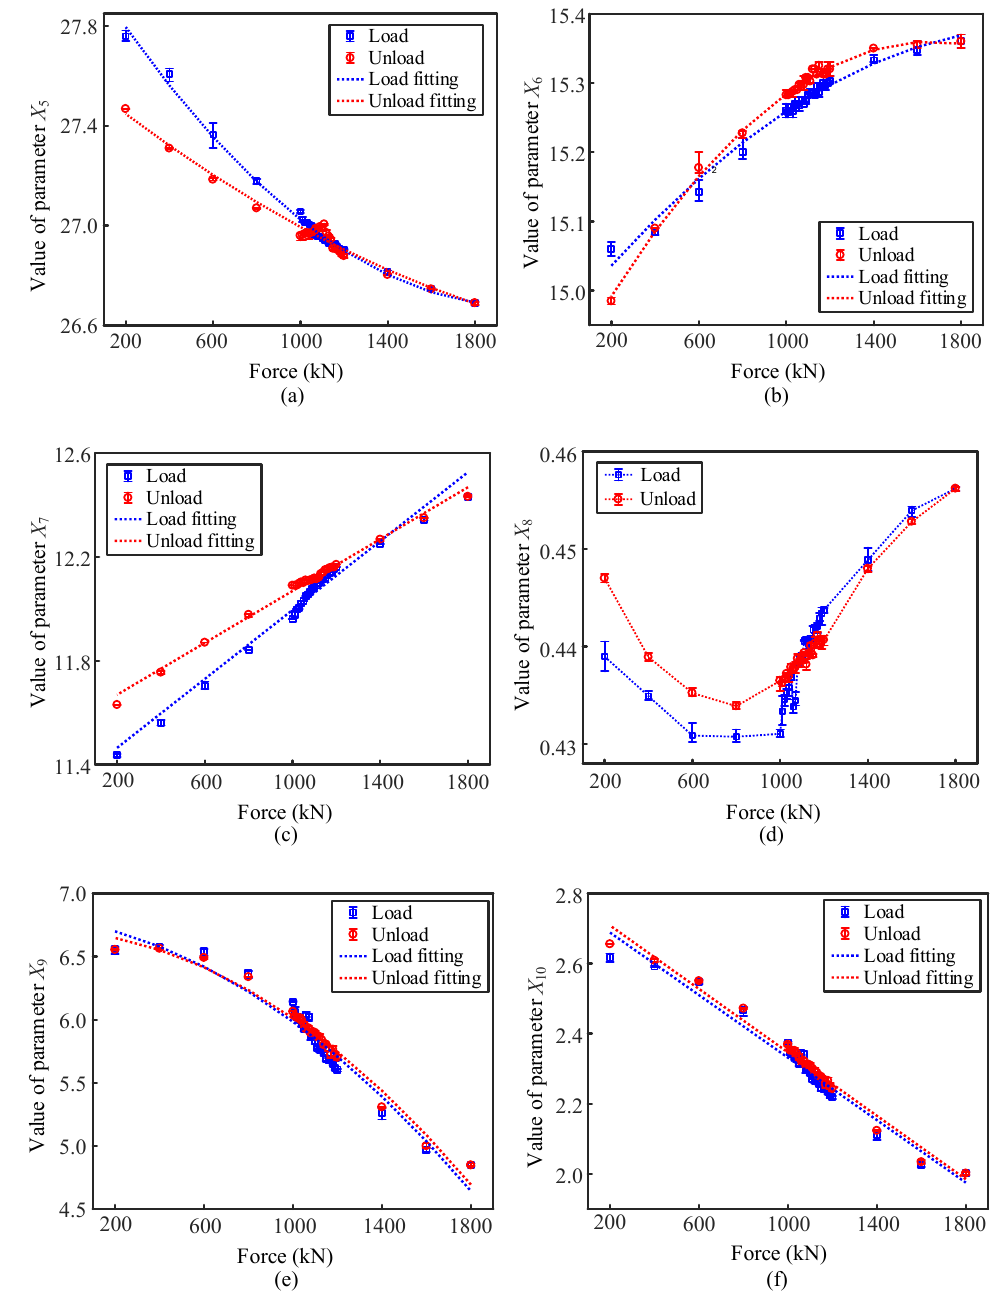
Figure 6. Calibration results about the parameters of ( a ) X 5 , ( b ) X 6 , ( c ) X 7 , ( d ) X 8 , ( e ) X 9 , and ( f ) X 10 . Table 3. Evaluation factors related to the performance of candidate